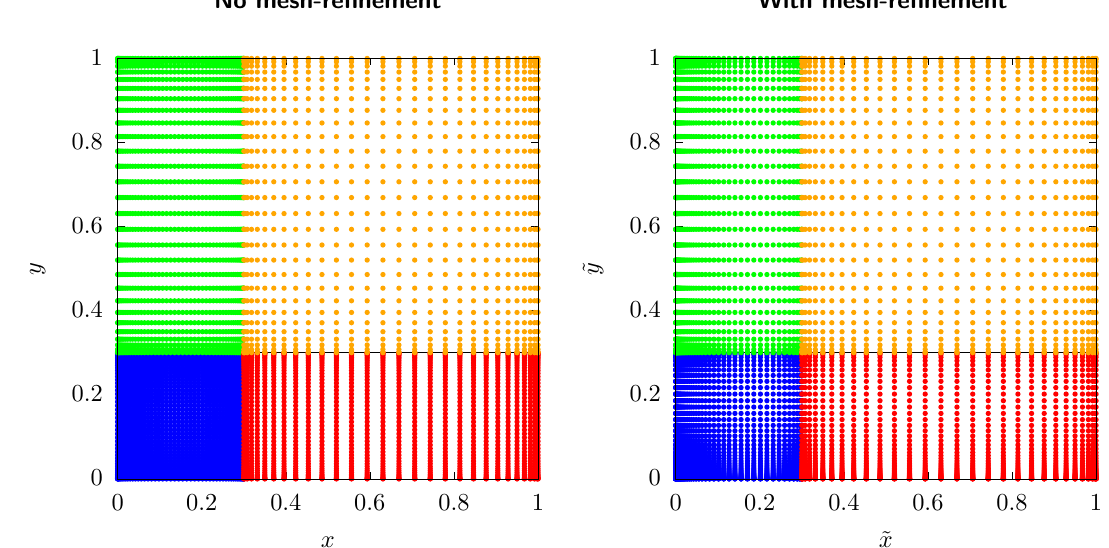
Figure 18. Physical grid to construct solutions with ‘ even, with grid parameters x ∗ = 0 . 3 = y ∗ . Left: simple Chebyshev grid points for the various patches. Right: mesh-refined grid points ˜ x = mesh ( x ; 0 , x ∗ , χ ) , ˜ y = mesh ( y ; 0 , y ∗ , χ ) , with χ = 4 , in the blue patch. In the green and red x y x,y patches only x - and y -directions need to be refined